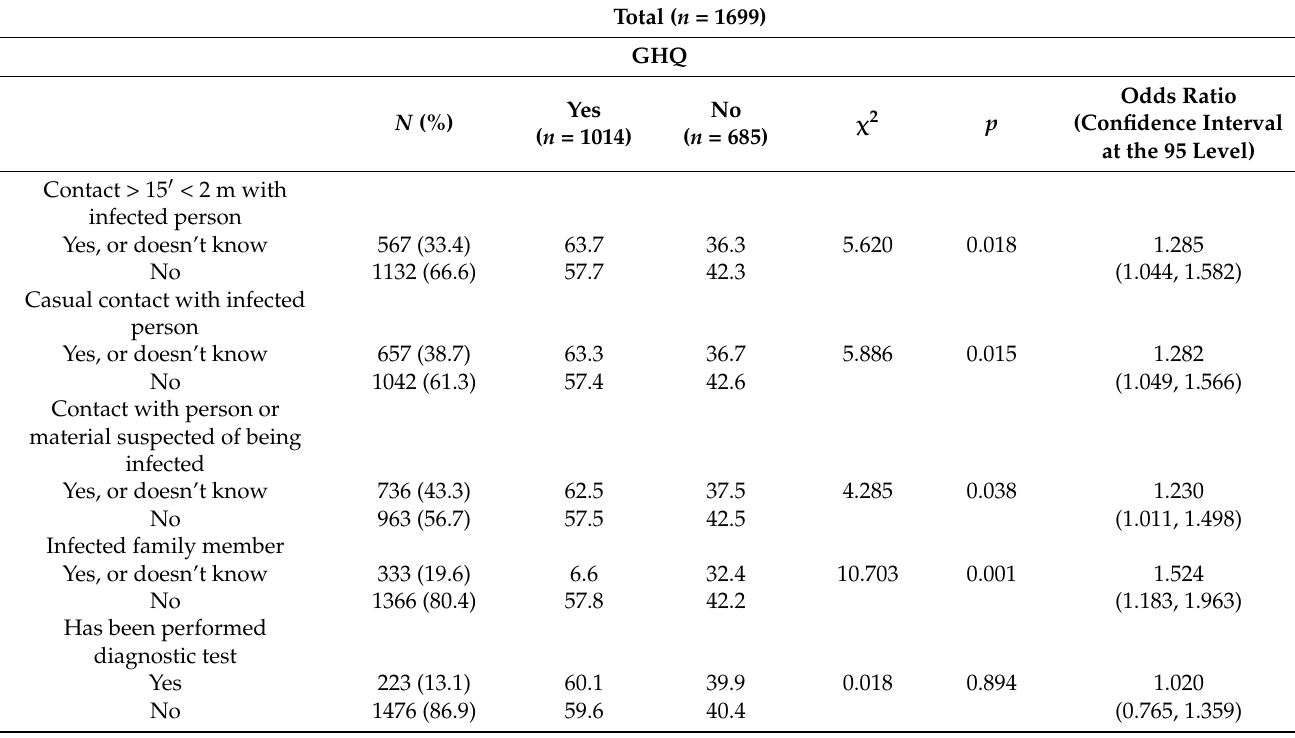
Table 4. Association between variables related to contact history and psychological distress during the pandemic.